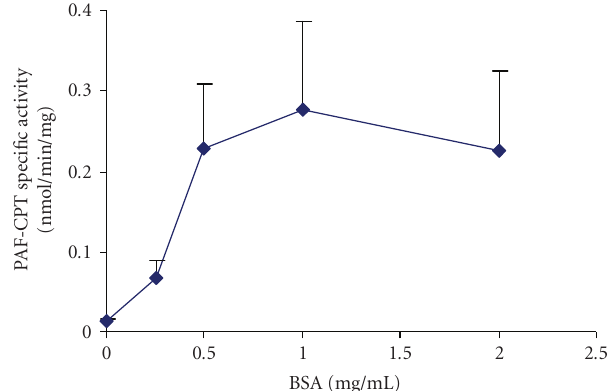
Figure 1: E ff ect of pH on PAF-CPT specific activity of mesangial cells: microsomal fractions of HMC 0.05 mg/mL were incubated in the presence of di ff erent bu ff er solutions. Results are the average of two independent determinations using di ff erent enzyme prepara- tions performing duplicate samples.